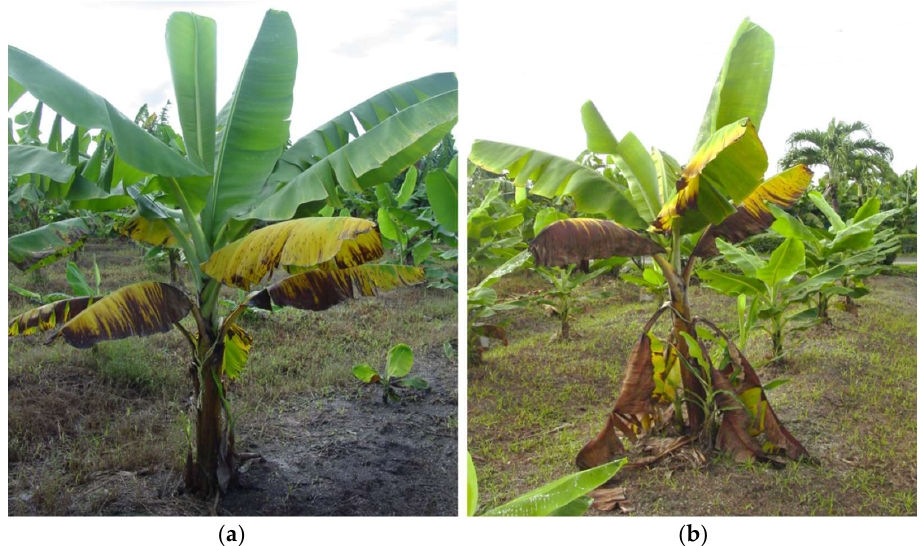
Figure 1. Symptoms of Banana Wilt disease in study area. ( a ) The yellow margins on the leaves and the necrotic stripes surrounded by the yellow margins on the lower or older leaves; ( b ) Set of dead leaves hanging from the pseudostem of a plant affected with Banana Wilt disease.